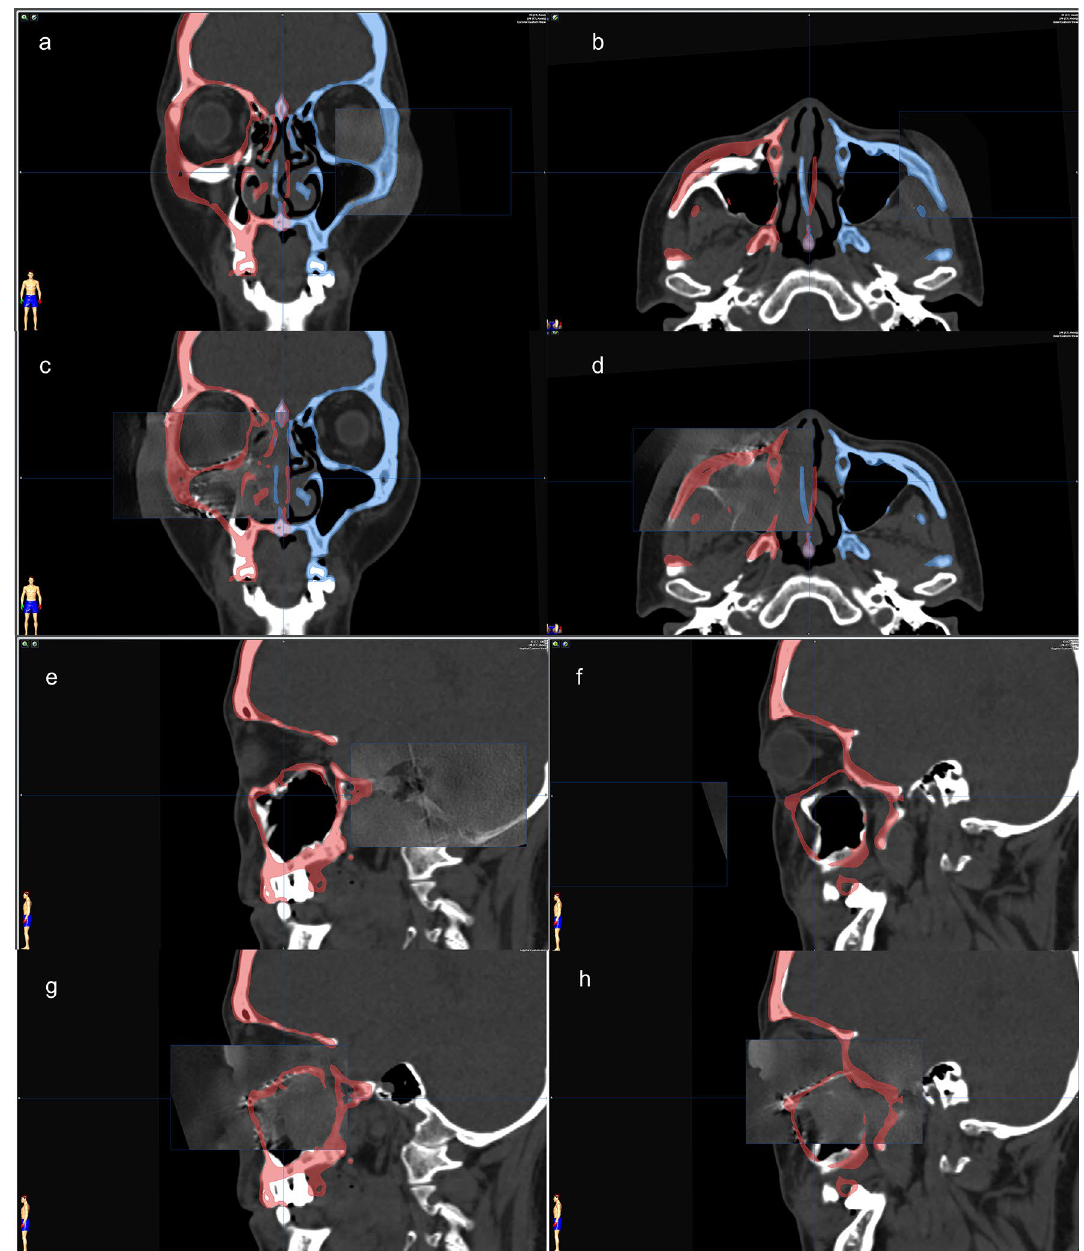
Figure 5. Fusion of preoperative computed tomography image, navigation presurgical planning, and intraoperative 3D C-arm computed tomography image. The intraoperative 3D C-arm computed tomography image is merged partially to the objects of navigation planning at the unaffected side (left) on the coronal and axial view ( a , b ). The updated position of the reduced zygoma and reconstructed orbital floor with implants ( c , d ). From different panels of the sagittal view, the preoperative images ( e , f ) and intraoperative images after implant positioning ( g , h ). The bone and implant contour accurately matched the presurgical